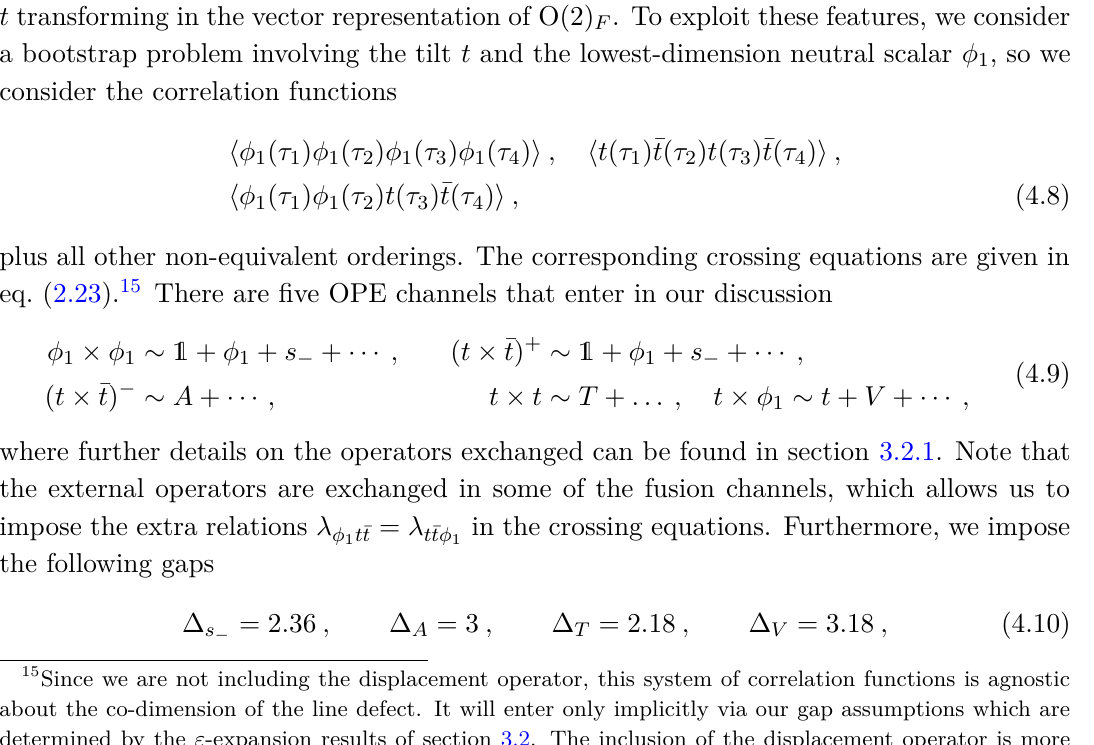
Figure 8. Bounds on the dimension of the first singlet in the Ψ s × ¯Ψ s OPE ∆ OPE coefficient of the displacement operator ( λ of the lowest-lying operators in all other channels are set to the unitarity bound. Parity-even and odd operators are set to have the same gaps. Λ = 21 , P = 41 and Λ = 33 , P = 53